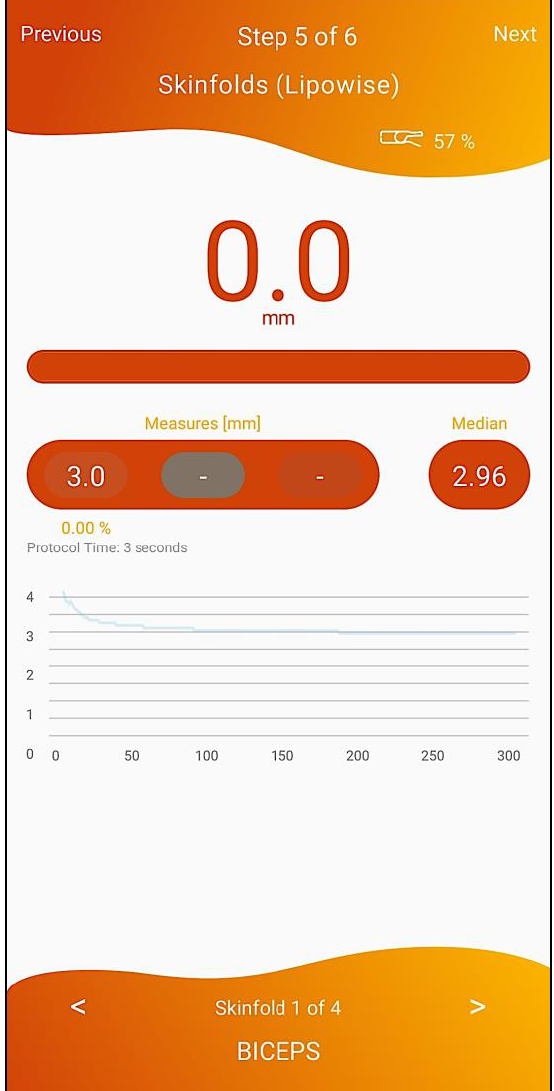
Figure 7. Biceps skinfold thickness evaluation with Lipowise.